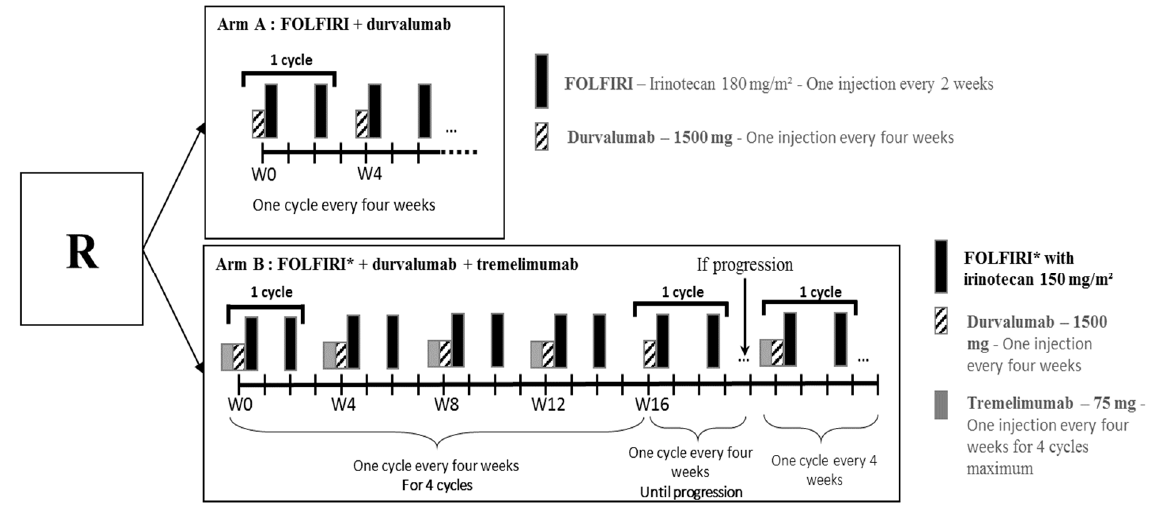
Figure 1. Treatment scheme of safety run-in phase.